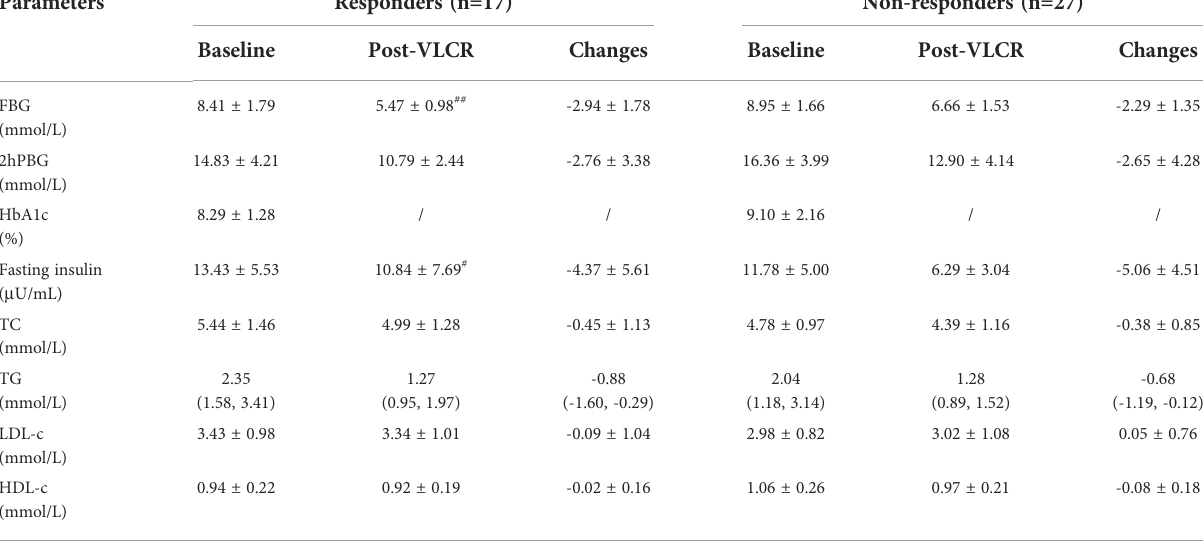
TABLE 3 Metabolic parameters pre- and post-VLCR in responders and non-responders. Parameters